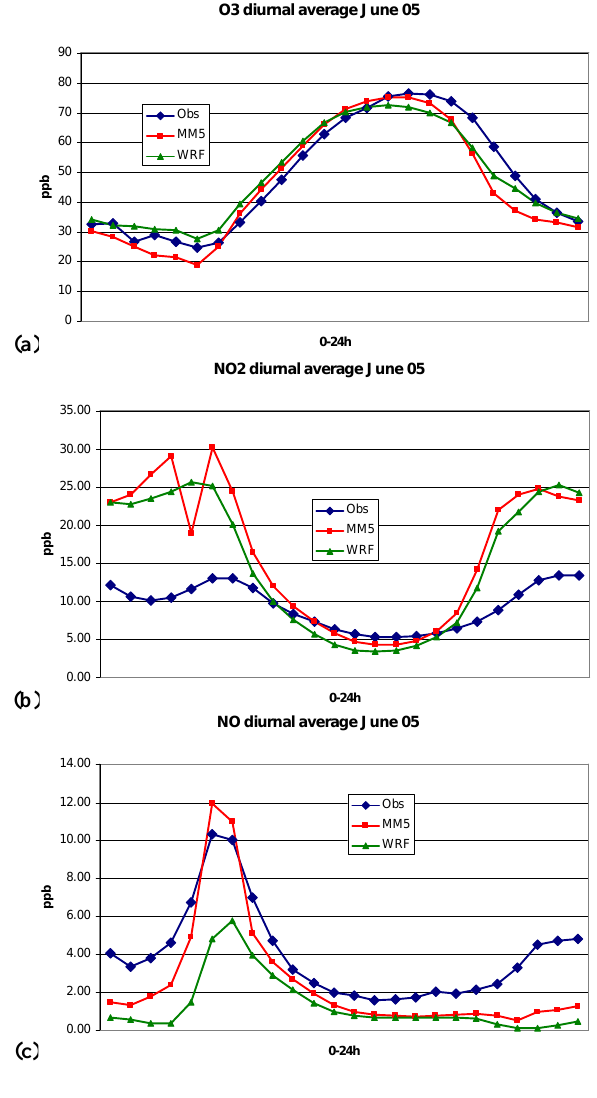
Fig. 6. Diurnal average of ozone (a) , NO 2 (b) and NO (c) for the observations (blue line) of the stations Ispra, Osio Sotto, Corte di Cortesi, Gambara and Varese, together with the calculated values by CHIMERE/MM5 (red line) and CHIMERE/WRF (green line), for June